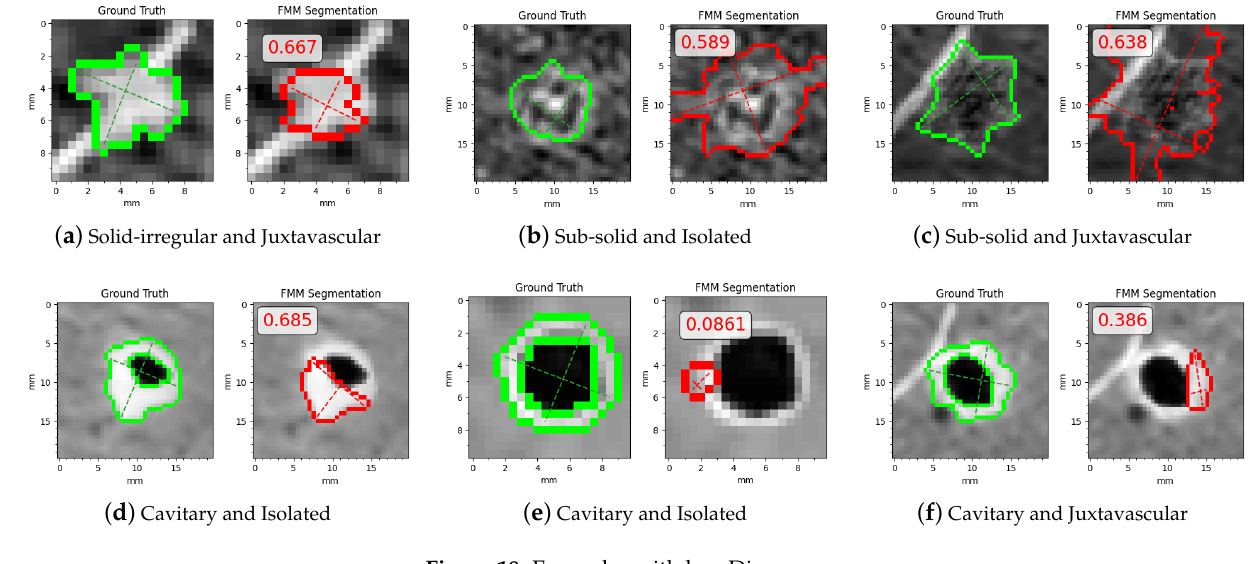
Figure 18. Examples with low Dice scores.